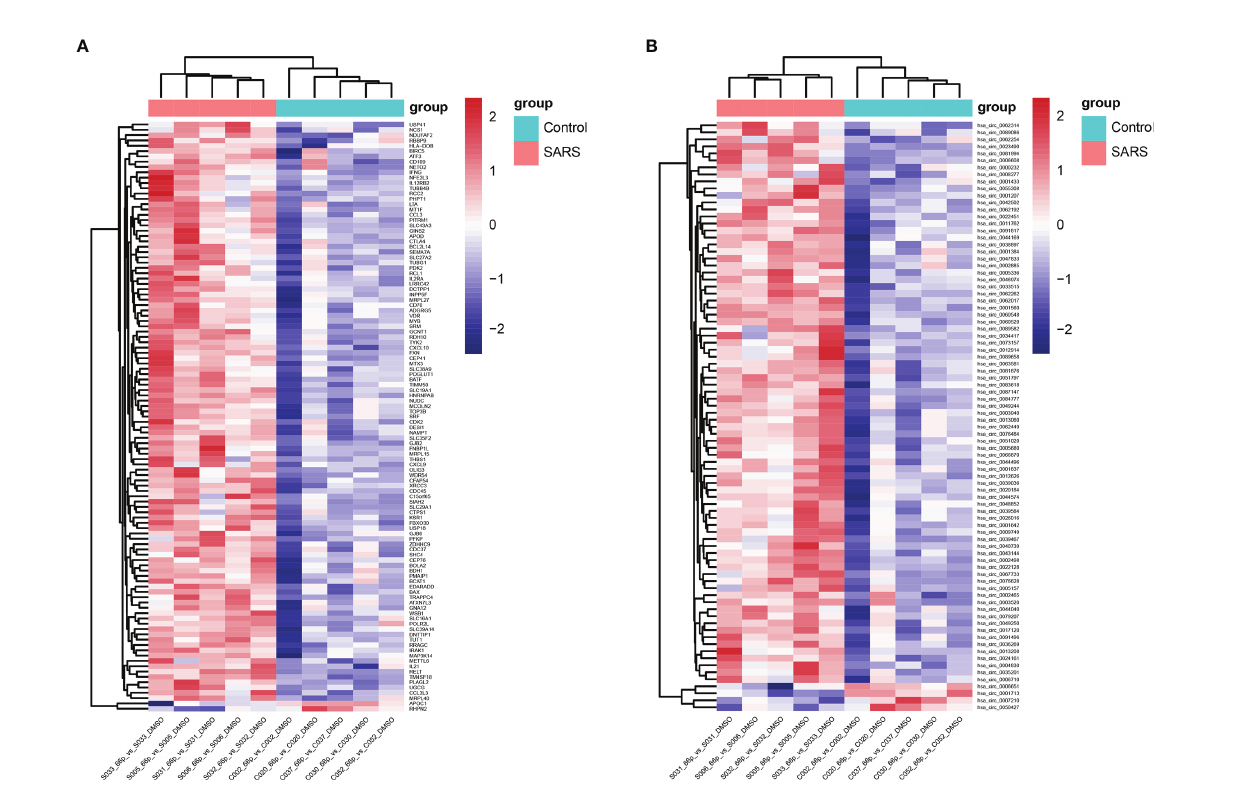
FIGURE 3 | Heatmap of transcriptomic pro fi ling. (A) Hierarchical clustering of differential expression of mRNAs. (B) Hierarchical clustering of differentially expressed